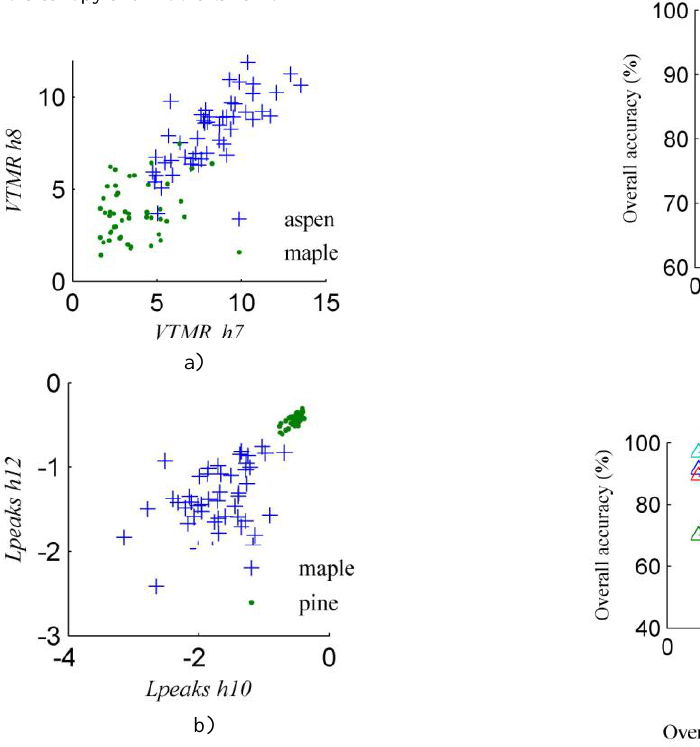
Figure 3. Scatter graphs of VTMR and Lpeaks features for species separation at stand level.